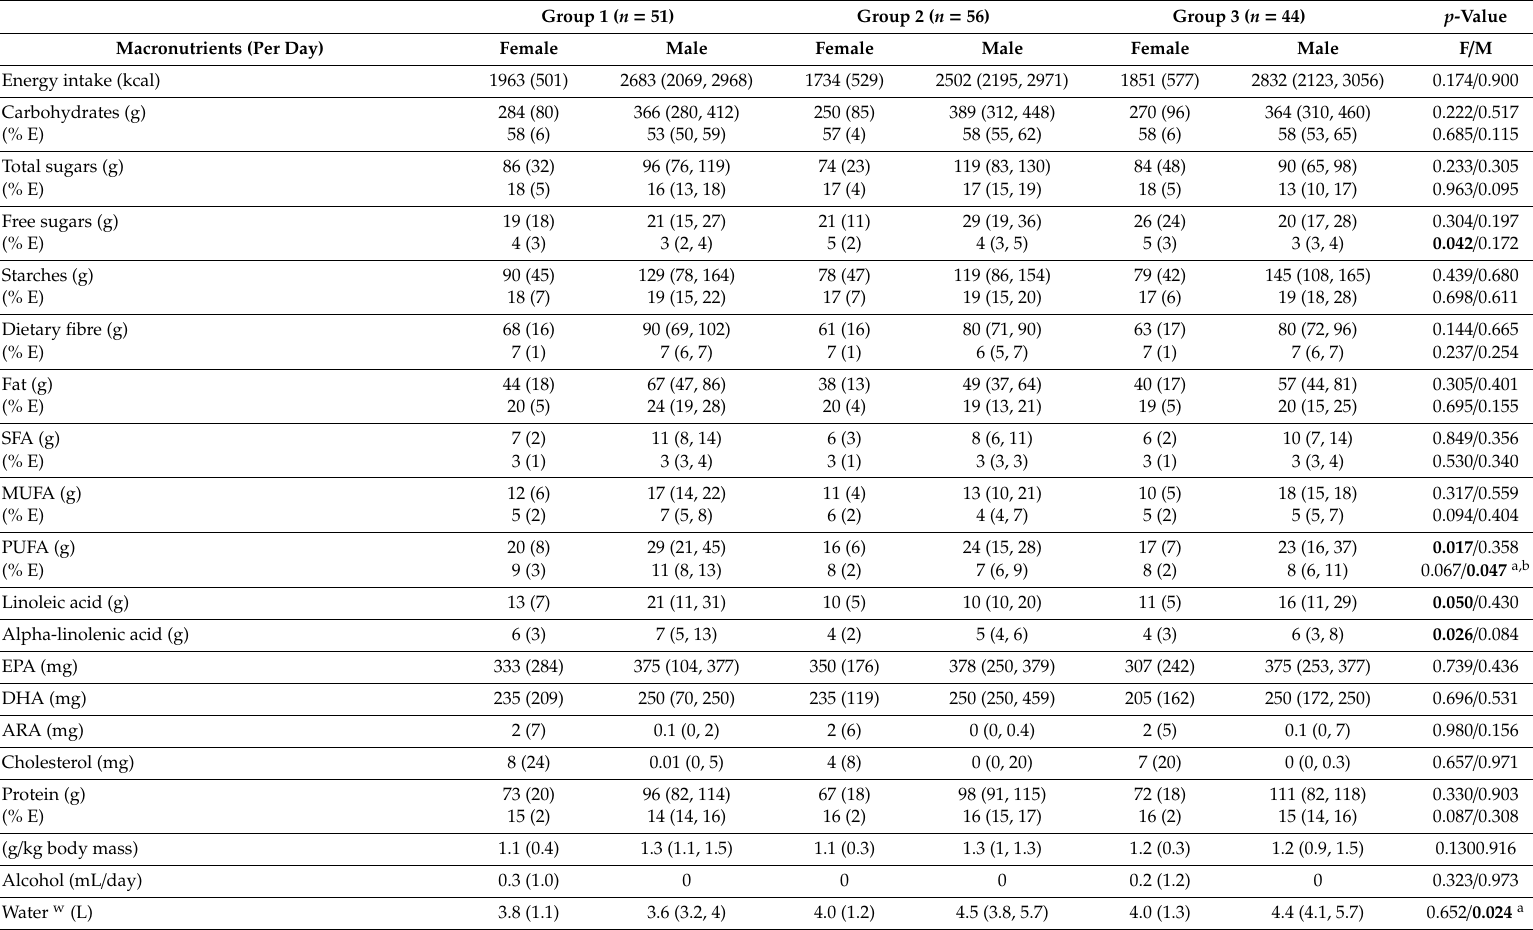
Table 2. Intake of energy and macronutrients by gender and to the time in WFPB lifestyle program: short (0.5– < 2 years), medium (2– < 5 years) and long-term (5–10 years) (groups (1, 2 and